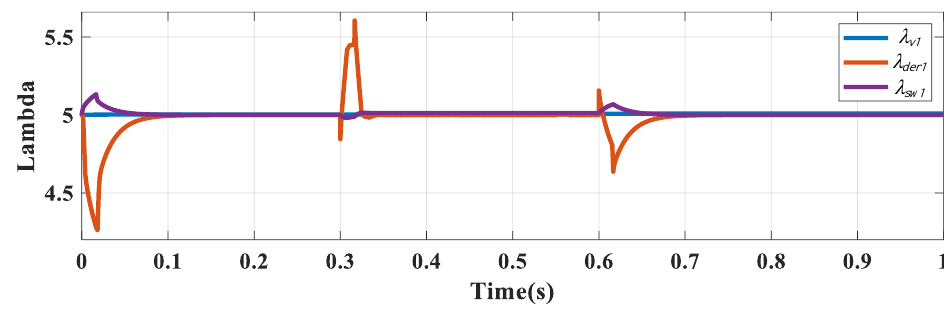
Figure 27. Study 4: generated weighting coefficients for FCS-MPC in DG1.